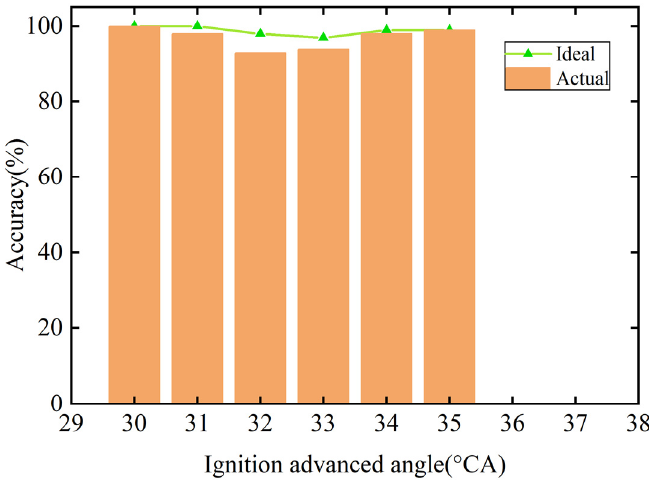
Figure 9. Compare of actual accuracy and ideal accuracy.